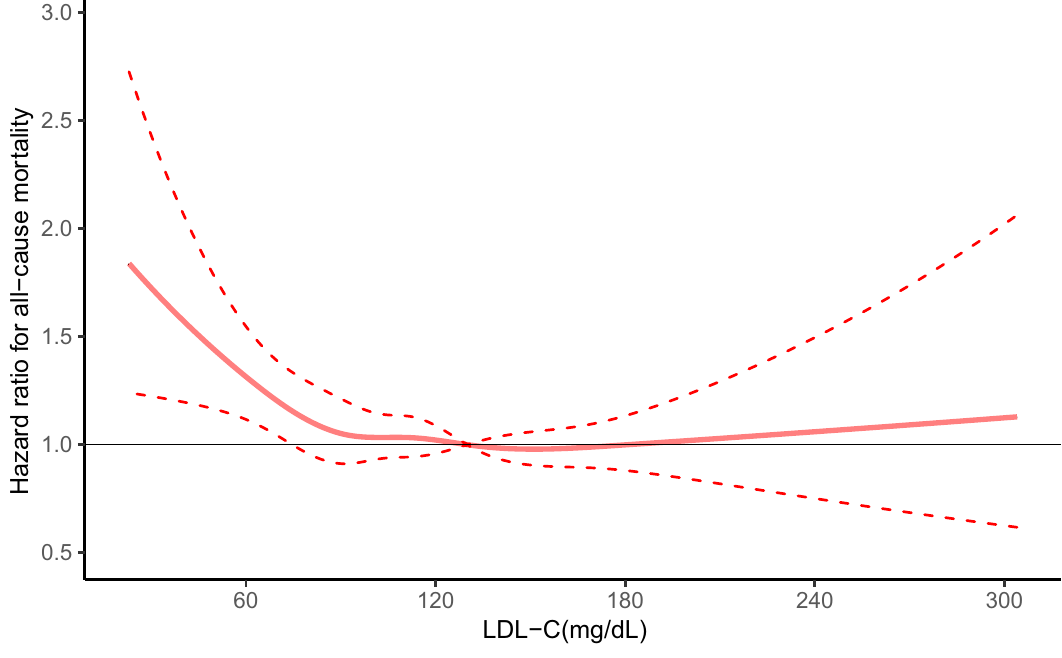
Figure 2. Spline plot of low-density lipoprotein cholesterol (LDL-C) level and all-cause mortality rate. The adjusted odd ratios and 95% confidence intervals (CIs) were calculated with logistic regression models after adjusting for age (continuous), sex, race, marital status, education level, smoking status, BMI (continuous), hypertension, diabetes, cardiovascular disease,